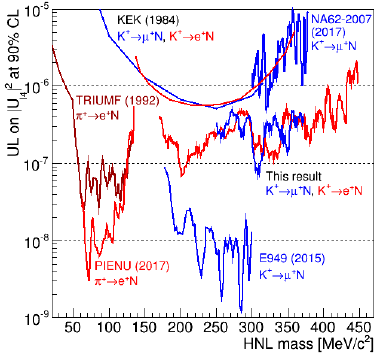
Figure 4. The 90% CL exclusion limit on the kinetic mixing parameter versus the mass of the Dark